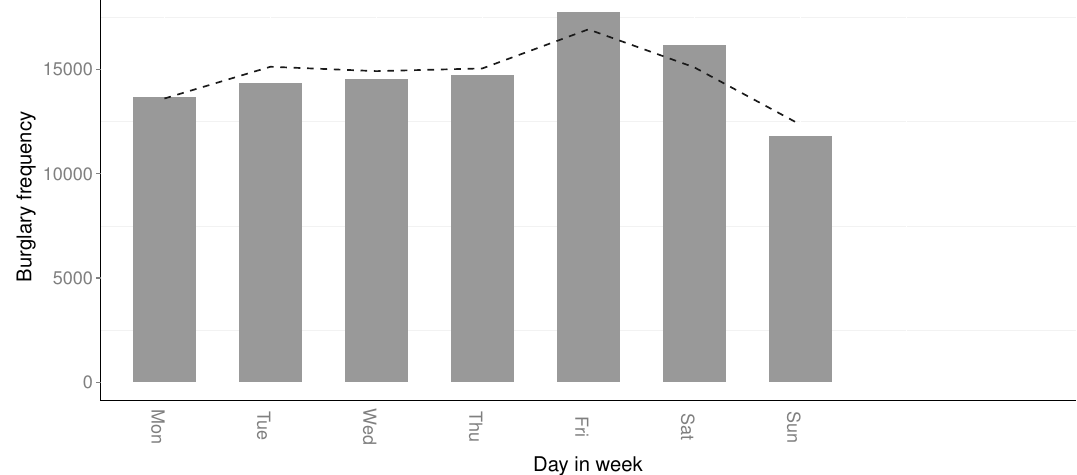
Figure 3. Aoristic distribution of all burglaries and attempted burglaries with the day in the week resolution between 2010 and 2014 with the baseline shown as a dashed line.